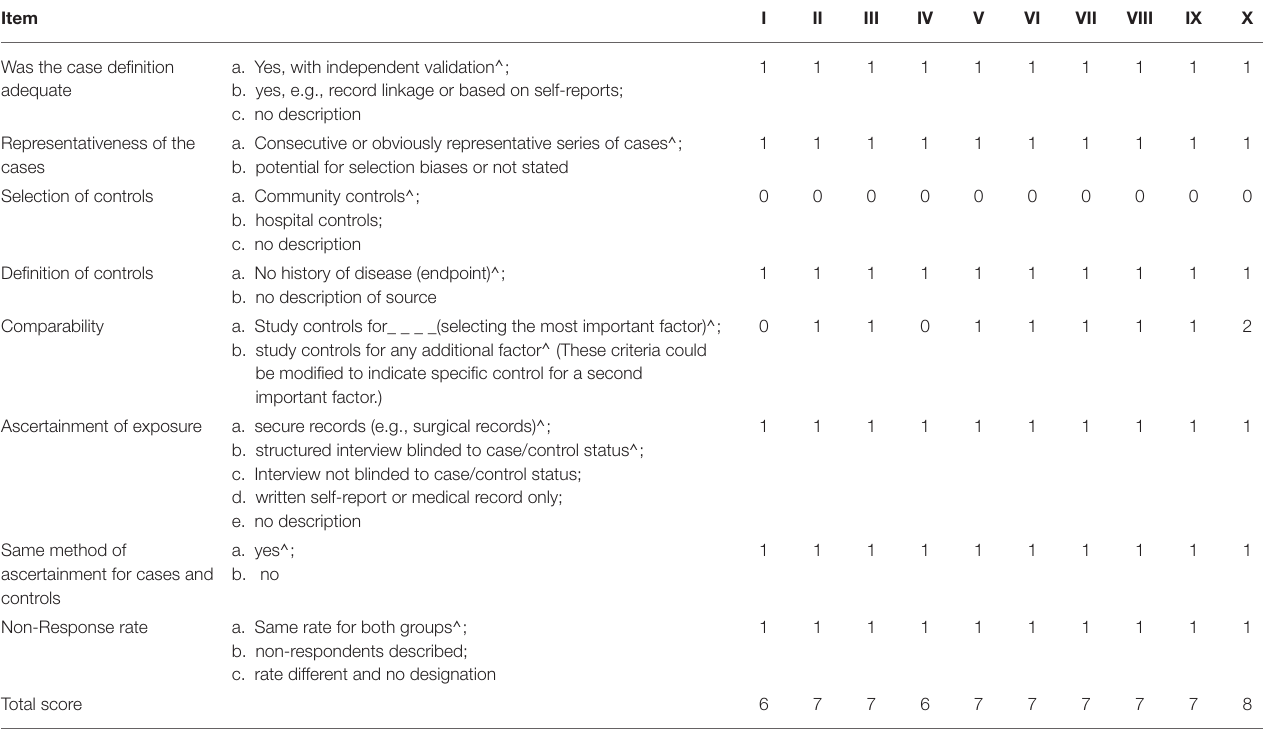
TABLE 3 | Newcastle-Ottawa Scale (case-control) for ten studies a included in this meta-analysis. Item